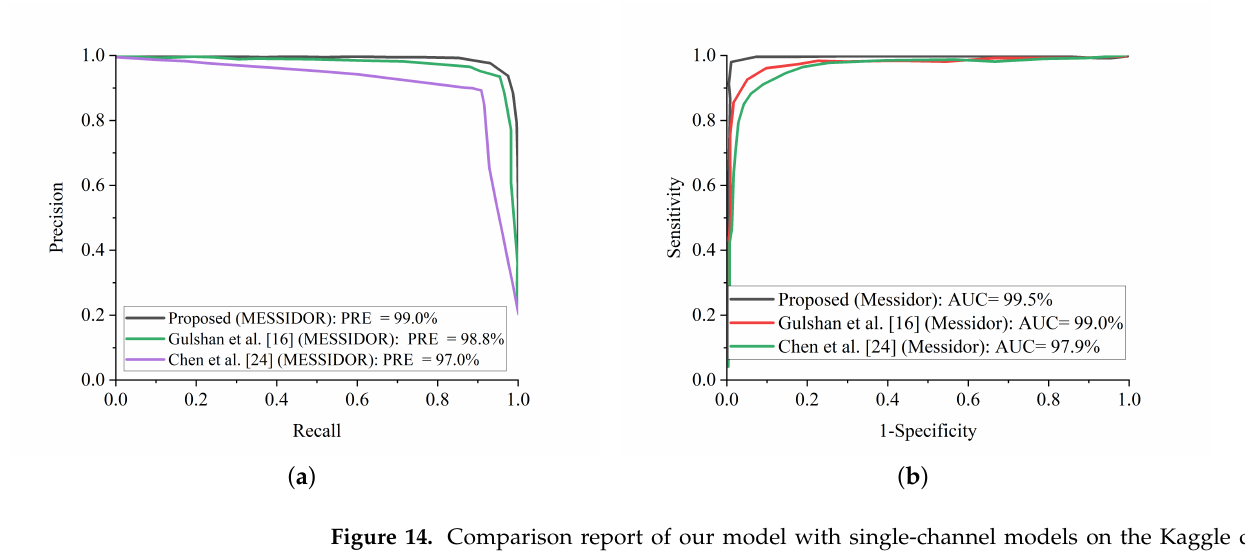
Figure 14. Comparison report of our model with single-channel models on the Kaggle dataset. ( a ) Precision-recall curve for our proposed model in comparison with some selected state-of-the-art methods on the Messidor dataset. ( b ) ROC curve for our proposed model in comparison with some selected state-of-the-art models on the Messidor dataset.